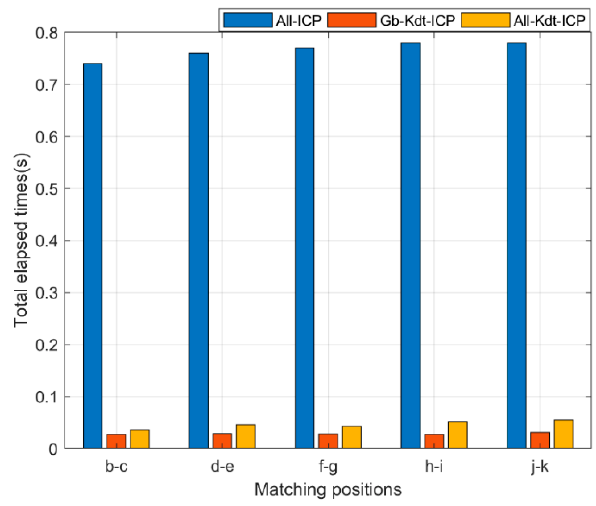
Figure 10. Time-consuming results of three matching algorithms.